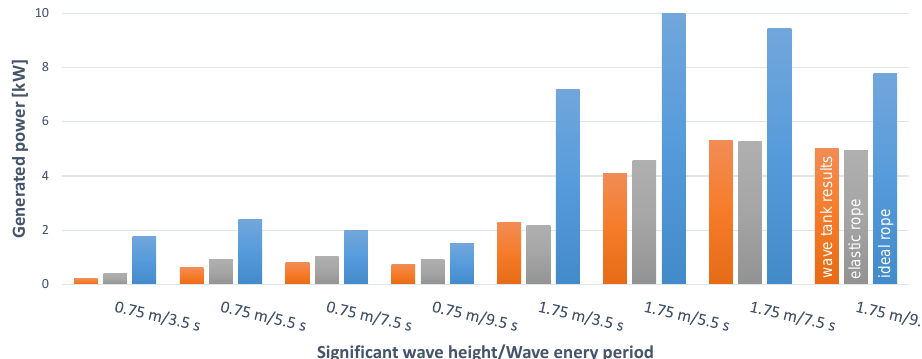
Figure 12. Comparison of the generated power in the physical wave tank tests ( orange ), the numerical simulation using a medium stiff line with c l = 133 kN/m and d l = 10 kN/m ( grey ) and the numerical simulation using an ideal stiff line with c l = 4 GN/m and d l = 1 kN/m ( blue ). The inertia was set to M = 53